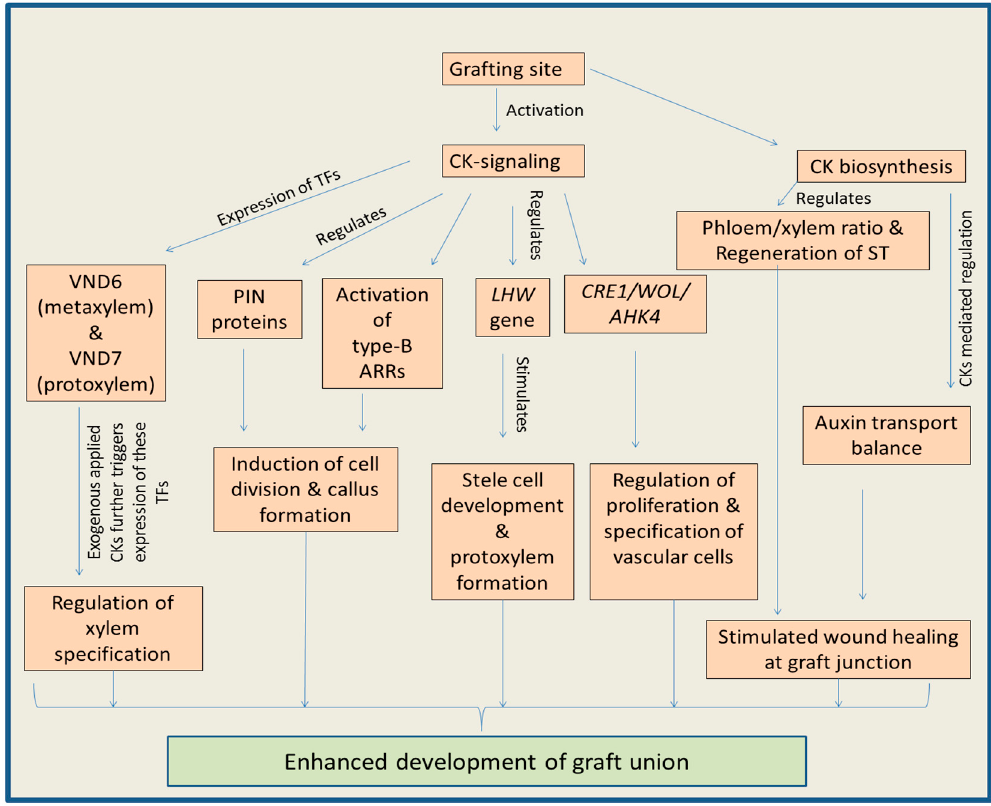
Figure 2. Diagram explaining how cytokinins regulate the process of plant grafting. It is a conclusion diagram, based on the various studies mentioned in the section related to cytokinins. Cytokinins (CKs); tracheary elements (TE); sieve tube (ST); PIN-FORMED auxin transport proteins (PIN); type-B Arabidopsis response regulators (type-b ARRs); VASCULAR-RELATED NAC-DOMAIN7 (VND); CYTOKININ RESPONSE 1 / WOODEN LEG / ARABIDOPSIS HISTIDINE KINASE 4 ( CRE1 / WOL / AHK4 ).